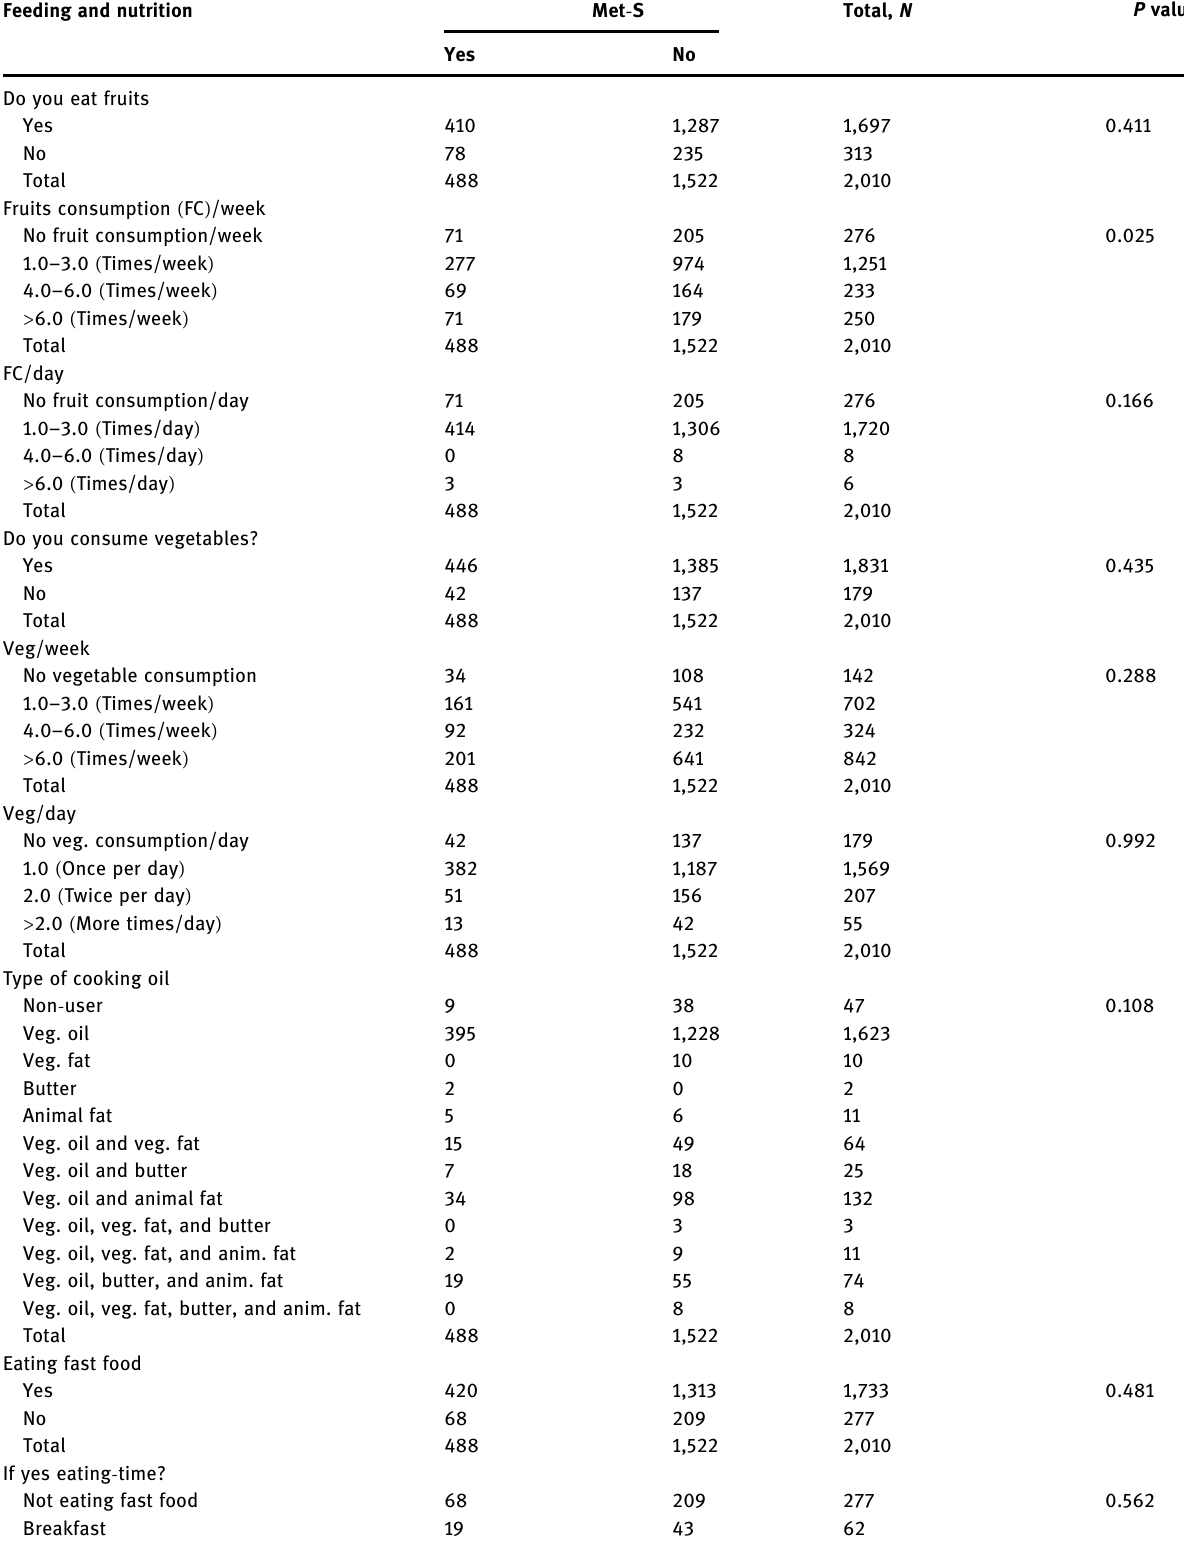
Table 3: Association of Met - S with feeding habits and nutrition Feeding and nutrition Met - S Total,